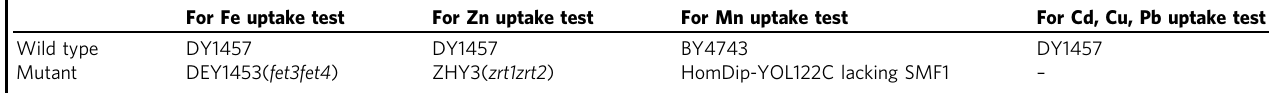
Table 1 Yeast strains used for functional